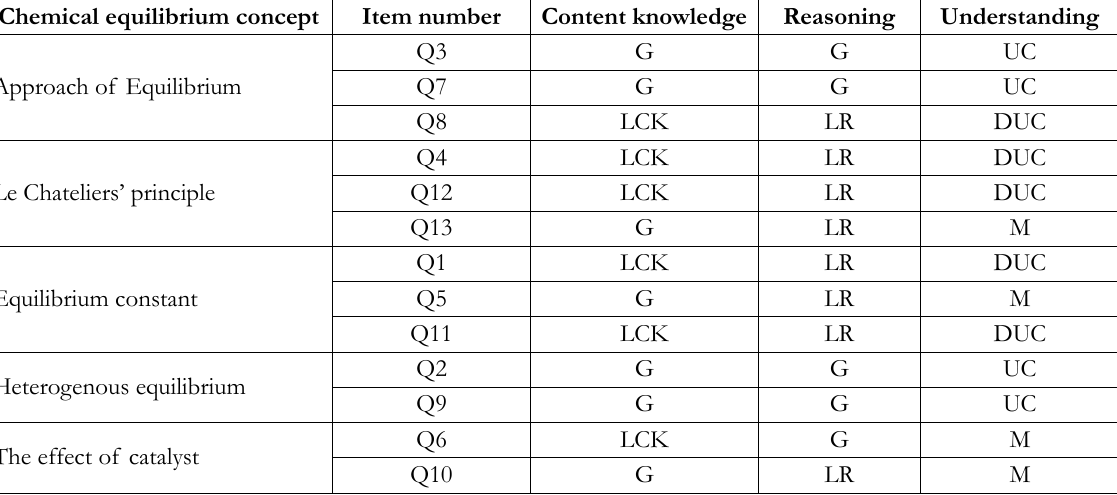
Table 9. Summary of students’ understanding of